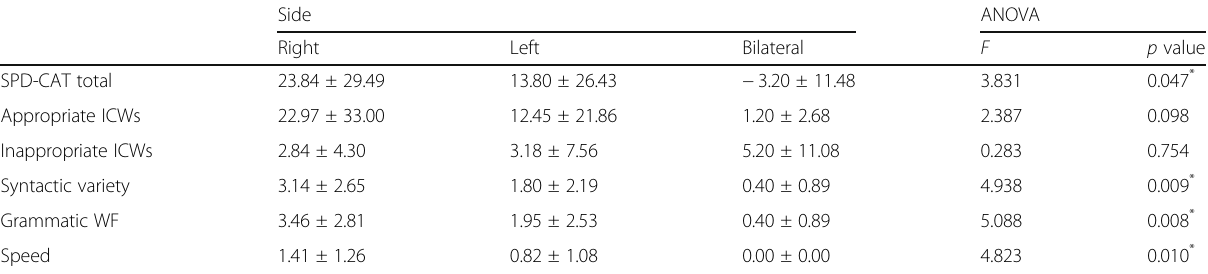
Table 10 Correlation between SPD-CAT language content units “ subscale scores ” with hemispheric lesion side of stroke Side ANOVA Right Left Bilateral F SPD-CAT